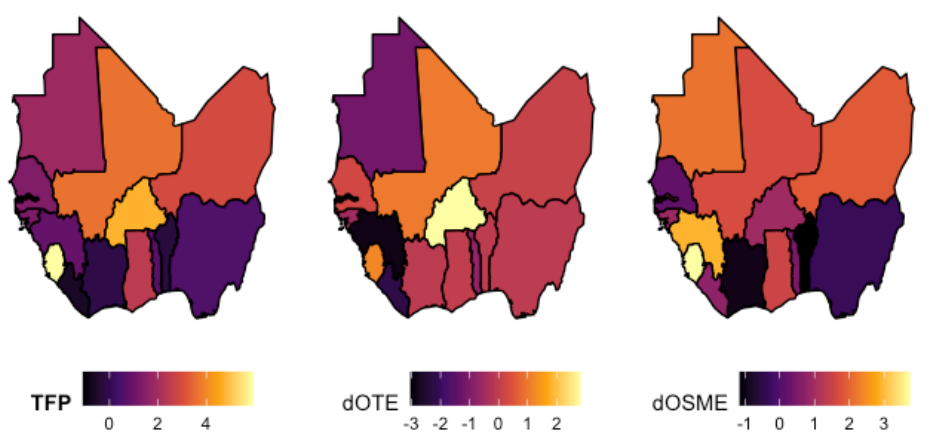
Figure 1. Agricultural productivity growth in West Africa as shown by TFP and components of TFPE, 2000–2016. Note: dTFP = Productivity Change, dOTE = Technical Efficiency Change and dOSME = Scale-Mix Efficiency.